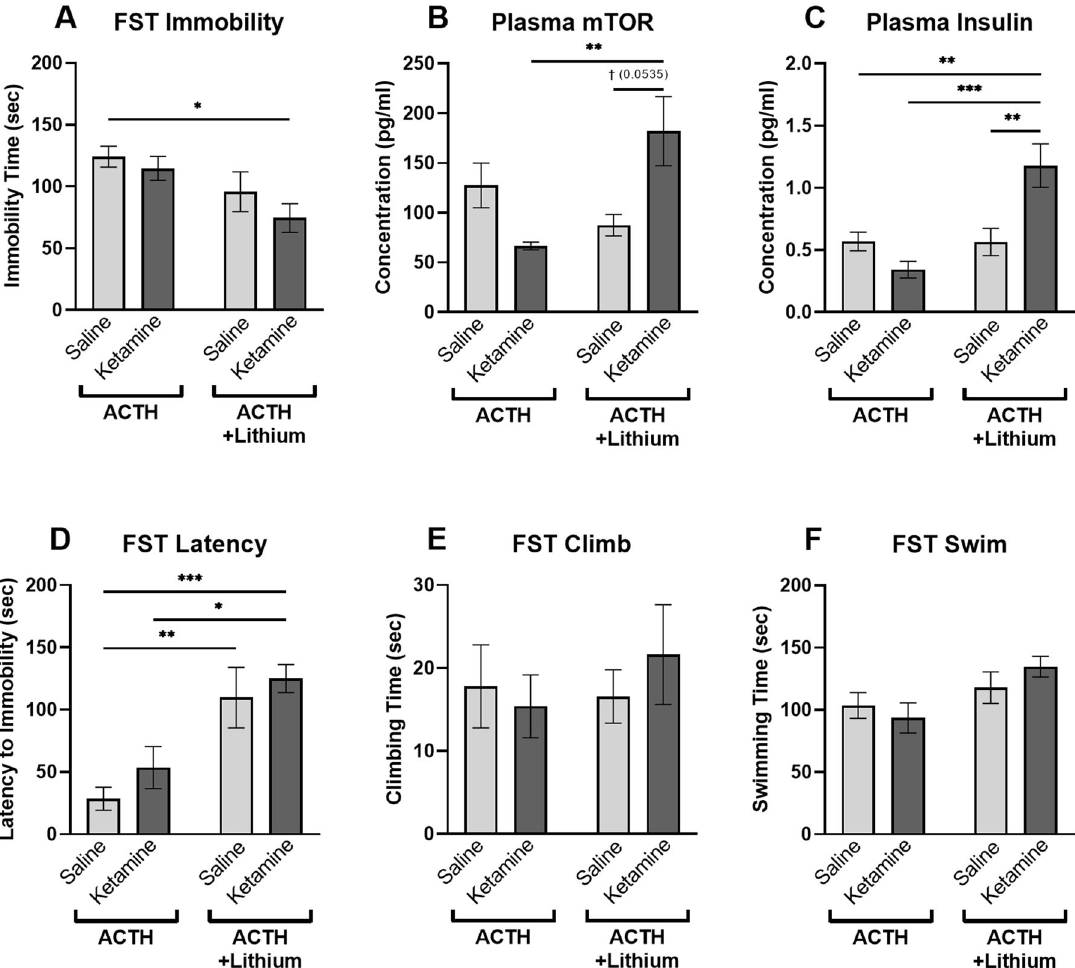
Fig. 1 Behavioral and biochemical measures following treatment administration. Following administration of ACTH, ACTH + ketamine, ACTH + lithium, or ACTH + ketamine + lithium, antidepressant-like ef fi cacy was determined according to time spent immobile ( A ), latency to immobility ( B ), swimming ( C ), or climbing ( D ) in the FST. In addition, biomarkers related to antidepressant effect were measured via ELISA, investigating expression of mTOR ( E ), GRIA1 ( F ), and insulin ( G ). ACTH adrenocorticotropic hormone, FST forced swim test, mTOR mammalian target of rapamycin, ELISA enzyme-linked immunosorbent assay, GRIA1 glutamate receptor, † p < 0.06; * p < 0.05; ** p < 0.01; *** p <